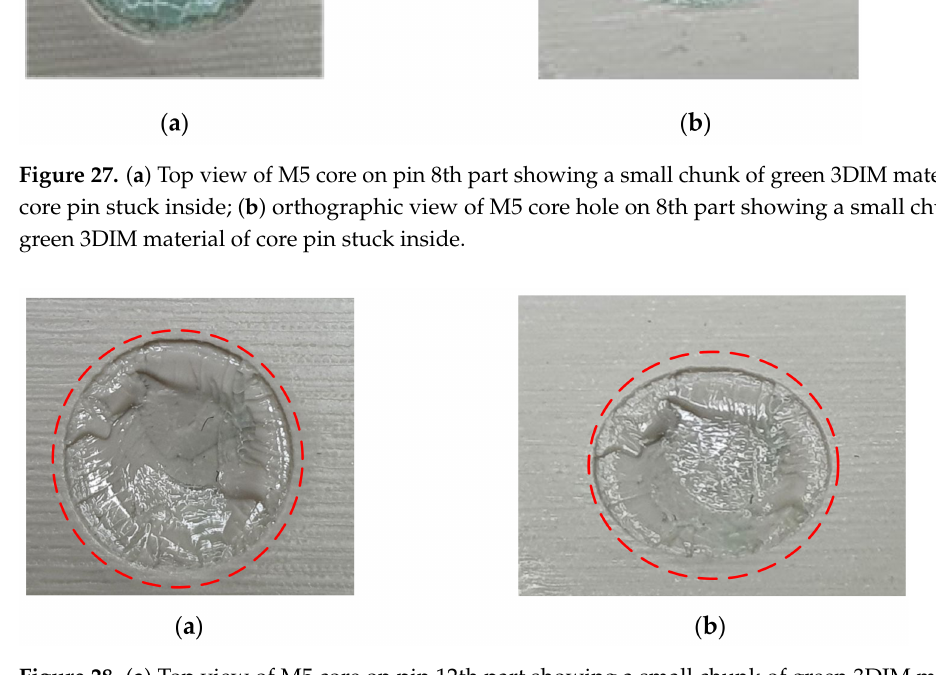
Figure 28. ( a ) Top view of M5 core on pin 12th part showing a small chunk of green 3DIM material of core pin stuck inside; ( b ) orthographic view of M5 core hole on 12th part showing a small chunk of green 3DIM material of core pin stuck